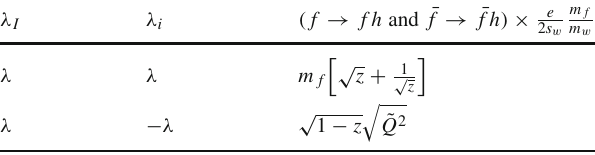
Table 4 Branching amplitudes for Higgs emission off